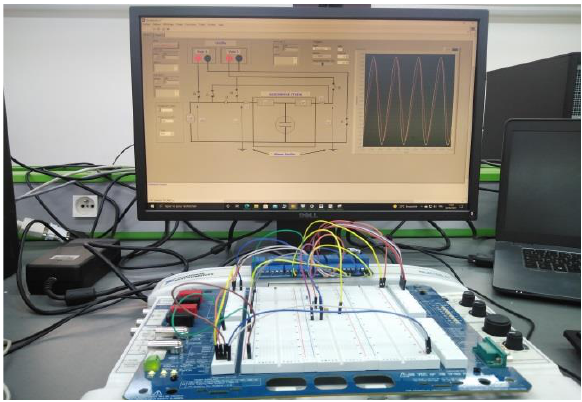
Figure 3. NI ELVIS II+ with LabVIEW environment